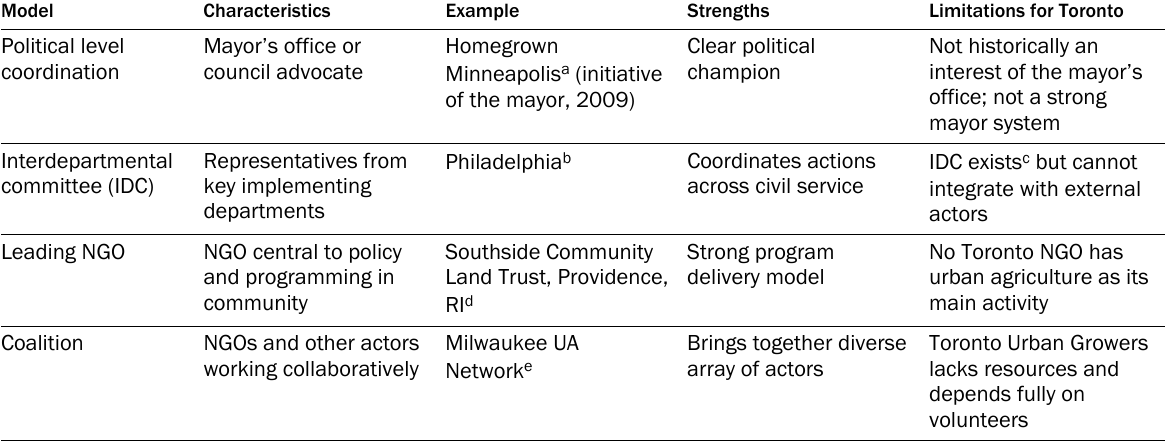
Table 2. Models for Municipal Urban Agriculture